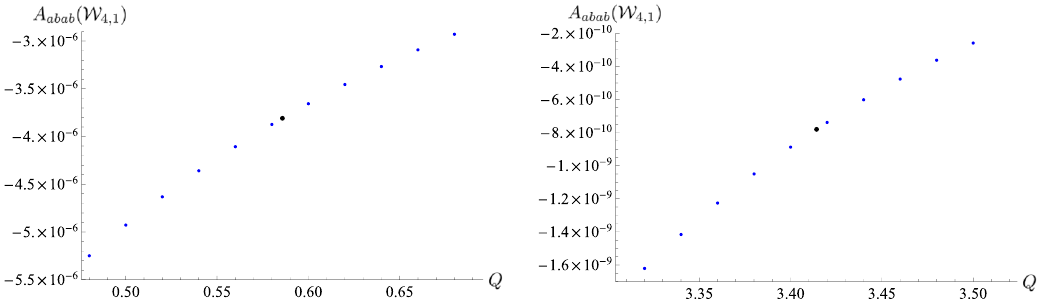
Figure 18 . The amplitudes A aaaa ( W 4 , 1 ) in the regions around Q = 4 cos 2 (cid:0) π (cid:1) Q = 4 cos 2 (right). The red dots are the bootstrap results and the black dots are the ex- 5 act expressions (4.98) and (4.102).